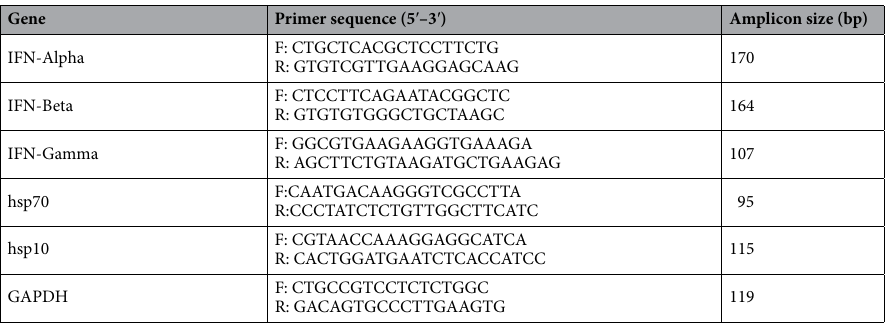
Table 14. Primer sequences used for mRNA expression analysis of hsp70, hsp10, IFN-alpha, IFN-beta, IFN-gamma and GAPDH genes in whole blood of transgenic and control birds at the age of 26 weeks. The annealing temperature for realtime PCR reactions was 58 °C. The expressions of hsp70 and hsp10 indicates the stress shown by blood cells. The expressions of 3 immune response genes namely, IFN-alpha, IFN-beta and IFN-gamma show the immune status of transgenic and control